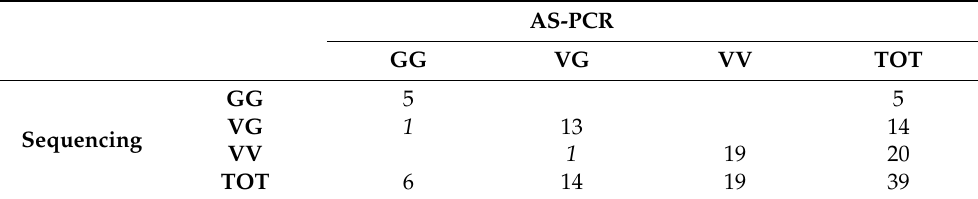
Table 2. Comparison of genotyping results obtained by sequencing the V1016G kdr mutation of the vssc gene in Aedes albopictus (rows) and with the novel AS-PCR assay (columns). Discordances are shown in italics. V = 1016V wildtype allele; G = 1016G kdr allele. AS-PCR GG VG VV